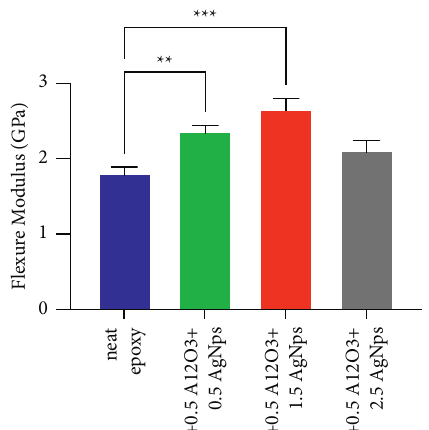
Figure 3: Flexure modulus for pristine bioepoxy and bioepoxy reinforced by various weight fractions of Al 2 O 3 -AgNps. Asterisks indicate that results significantly different to the unmodified control ( ∗∗ p < 0 . 01; ∗∗∗ p < 0 .